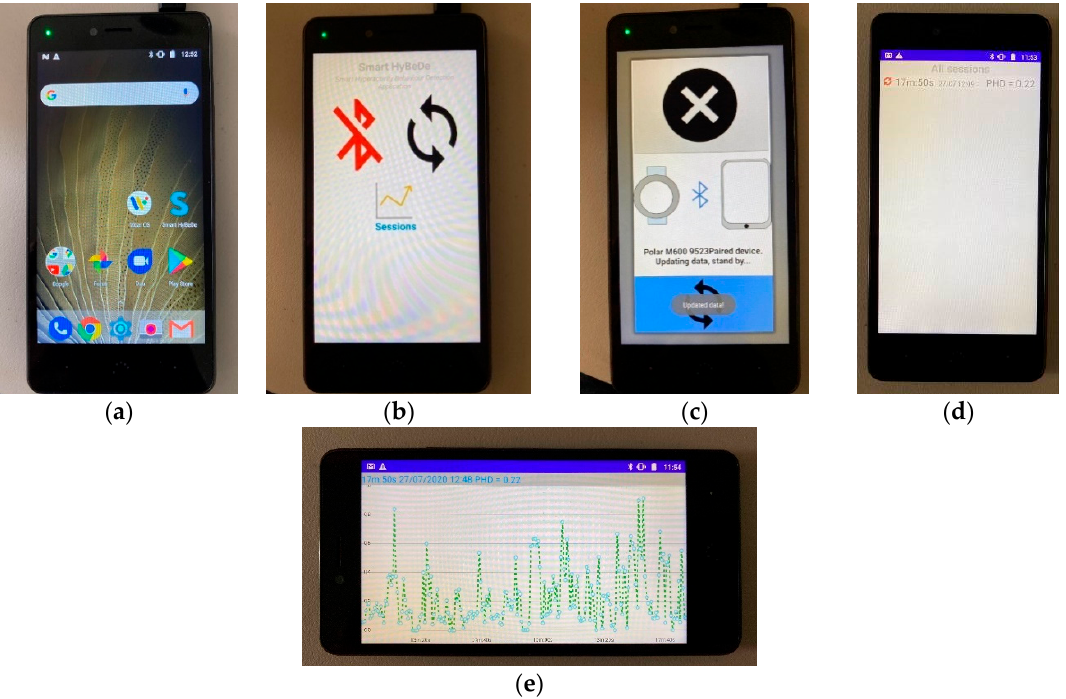
Figure 4. Proposed mobile device, BQ Aquaris M5: ( a ) Smart HyBeDe application installed on the mobile device. ( b ) Main screen showing options of Smart HyBeDe app: pair with a wearable device, synchronize data sessions, and view the processed sessions with the proposed model. ( c ) Synchronization screen getting the new session files from the wearable device. ( d ) Sessions screen in the mobile device and ( e ) display screen of the fuzzy protoform in the mobile device.